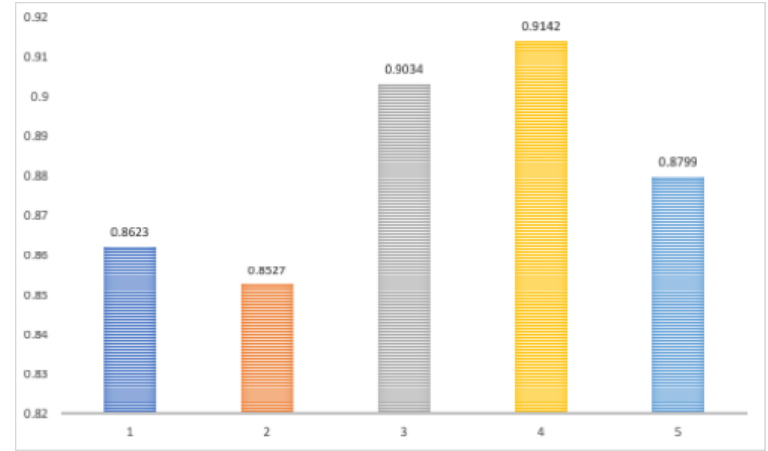
Figure 10. Five-foldcross-validation